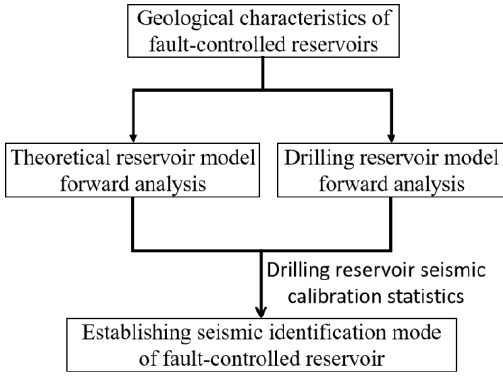
Figure 2. A chart of the research work flow.